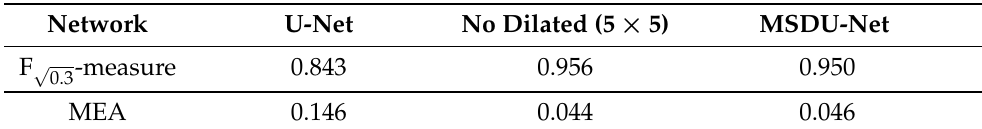
Table 3. Quantitative comparison of F √ normal convolution kernels), MSDU-net and U-net.